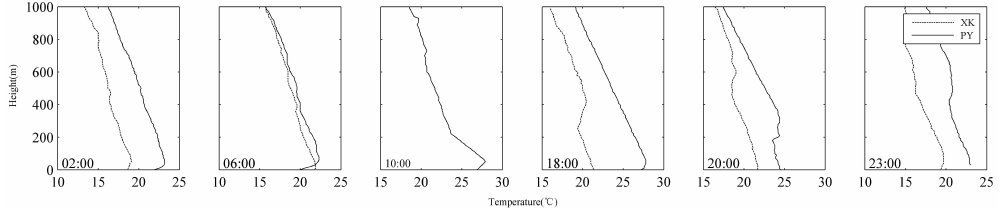
Fig. 8. Time series of vertical temperature profiles on 16 October